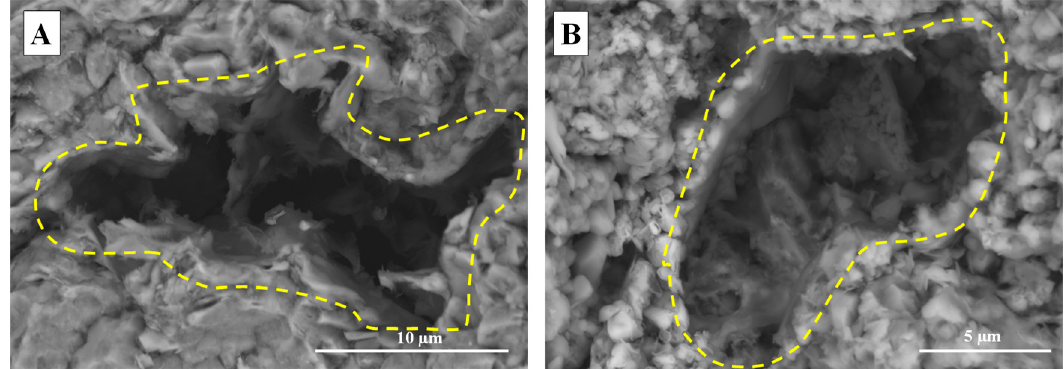
Figure 5. Voids initially filled with OM. SEM images of the samples after the experiment ( A ) sample 12, ( B ) sample #16.